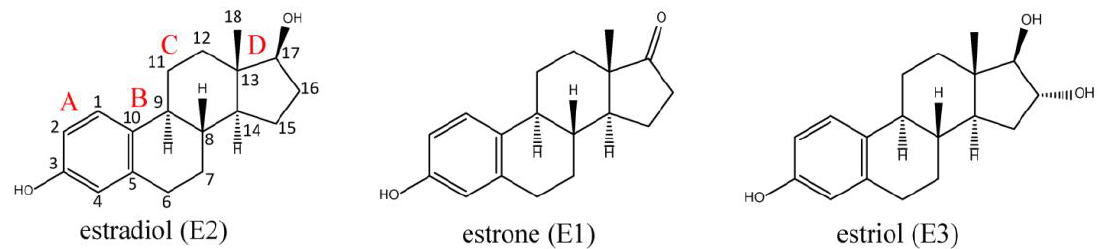
Figure 5. Structures of natural estrogens: estradiol (E2, the most potent), estrone (E1) and estriol (E3). The four rings of the endogenous ligand, E2, are labelled A-D according to the widely accepted naming